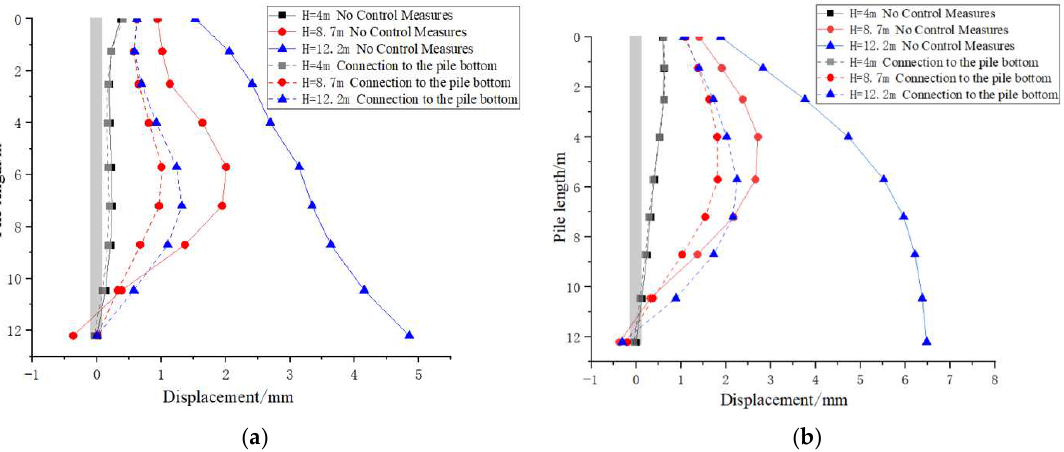
Figure 10. Comparison curve before and after connection to pile bottom: ( a ) pile Z2; ( b ) pile Z3.